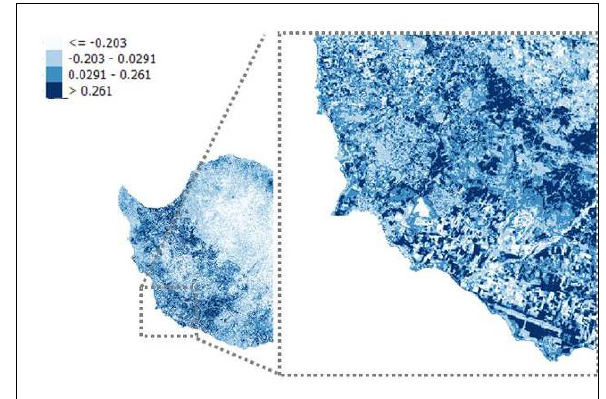
Figure 8 Difference in C-factor over nearly last 30years observed false colour: the more significant changes potentially impacting the erosion of the soil in Paphos District are highlighted in blue and dark blue